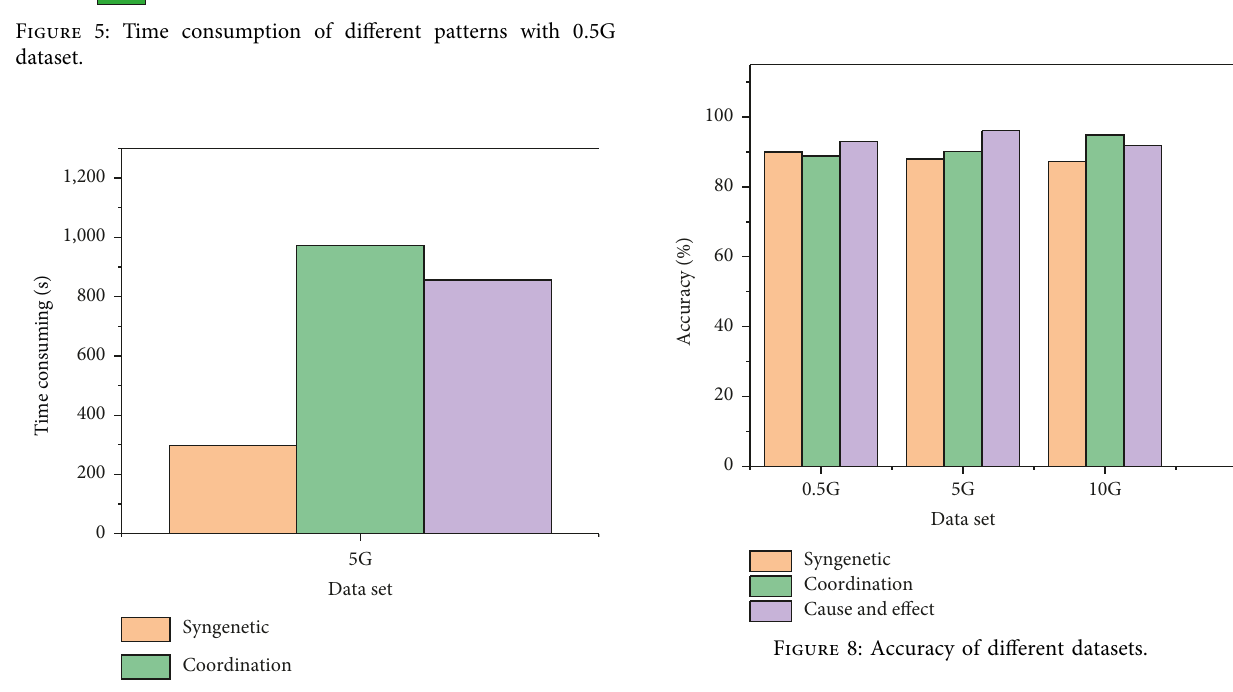
Figure 7: Time consumption of different patterns with 10G dataset.